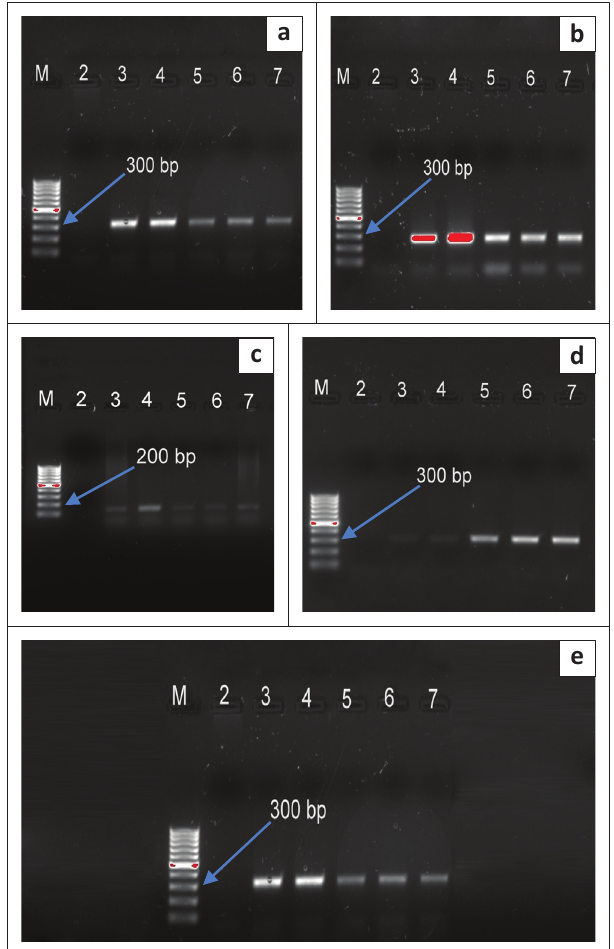
bp, base pairs. FIGURE 3: Amplification of Eimeria species by polymerase chain reaction. M: 100 bp DNA marker; L2: negative control; L3–7: samples. (a) Eimeria mitis 328 bp; (b) Eimeria tenella 278 bp; (c) Eimeria maxima 145 bp; (d) Eimeria acervulina 321 bp; (e) Eimeria brunetti 311